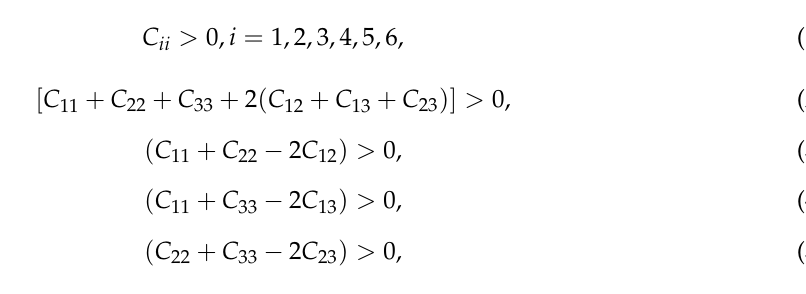
Table 2. The elastic constants (in GPa) and the elastic modulus (in GPa) of o C12-AlAs, h P6-AlAs, and diamond-AlAs under